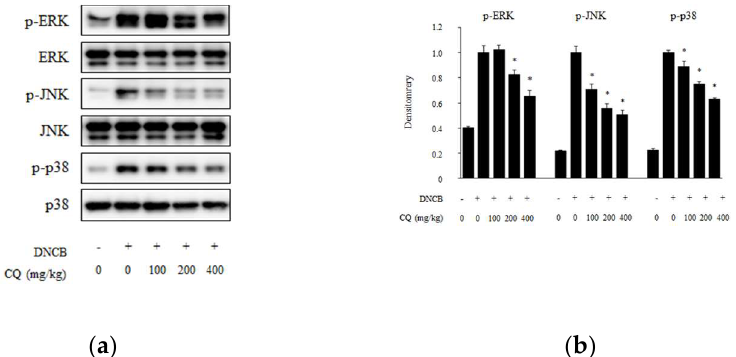
Figure 8. Phosphorylation of mitogen-activated protein kinase (MAPK) on dorsal skin lesions in DNCB-induced BALB/c mice. ( a ) To demonstrate the effect of CQ in DNCB-induced BALB/c mice, the tissues were collected, homogenized, and lysed in ice-cold lysis buffer at the end of the experiment. The expression of total protein was measured by western blotting; ( b ) The activities of phospho (p)-ERK (extracellular signal-regulated kinase), p-JNK (c-jun N-terminal kinase), and p-p38 were determined by densitometry protocol. All data are presented as mean ± SD; * p < 0.05 vs. DNCB-induced group.